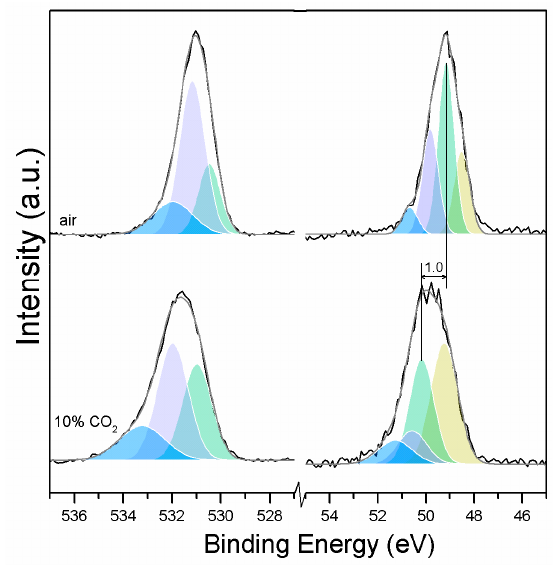
Figure 6. O1s ( left ) and Mg2p ( right ) peaks for samples exposed to air and 10% CO 2 . Table 5. Mg2p and O1s peak information for samples exposed to air and 10% CO 2 .